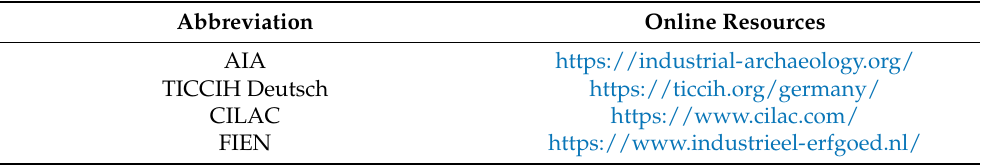
Table A1. Schedule of main industrial heritage inspection and research institutions in Western European countries.